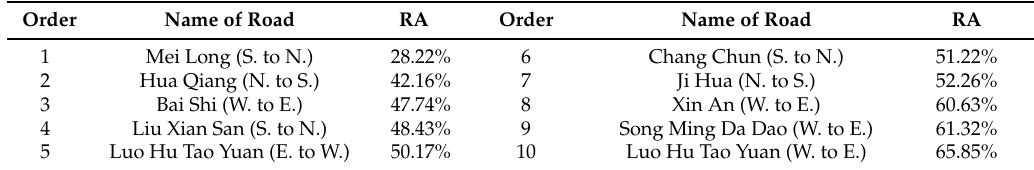
Table 1. First ten congestion-prone roads in